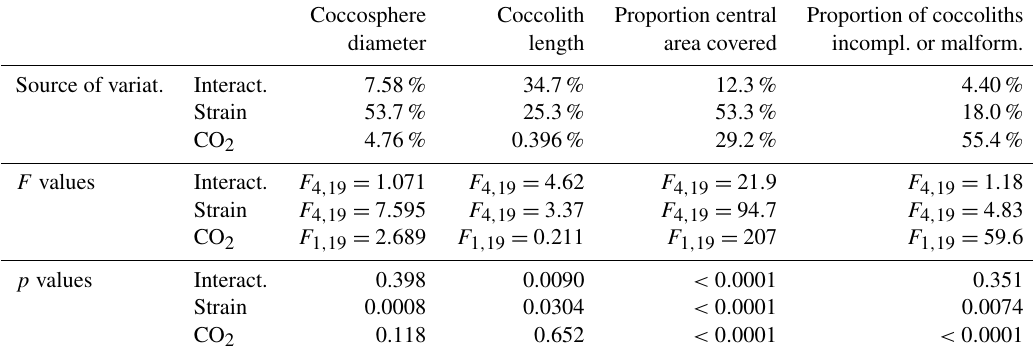
Table 4. Global two-way ANOVA results for coccosphere and coccolith parameters of strains exposed to high-CO 2 –low-pH conditions vs. control CO 2 treatment. Proportions of central area covered and of incomplete or malformed coccoliths were arcsine-square-root transformed prior to